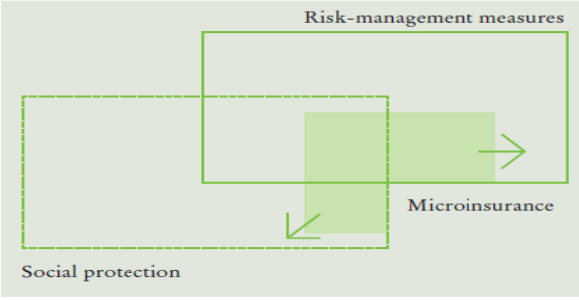
Figure 1: The Locus of Microinsurance; Source: Jacquier,